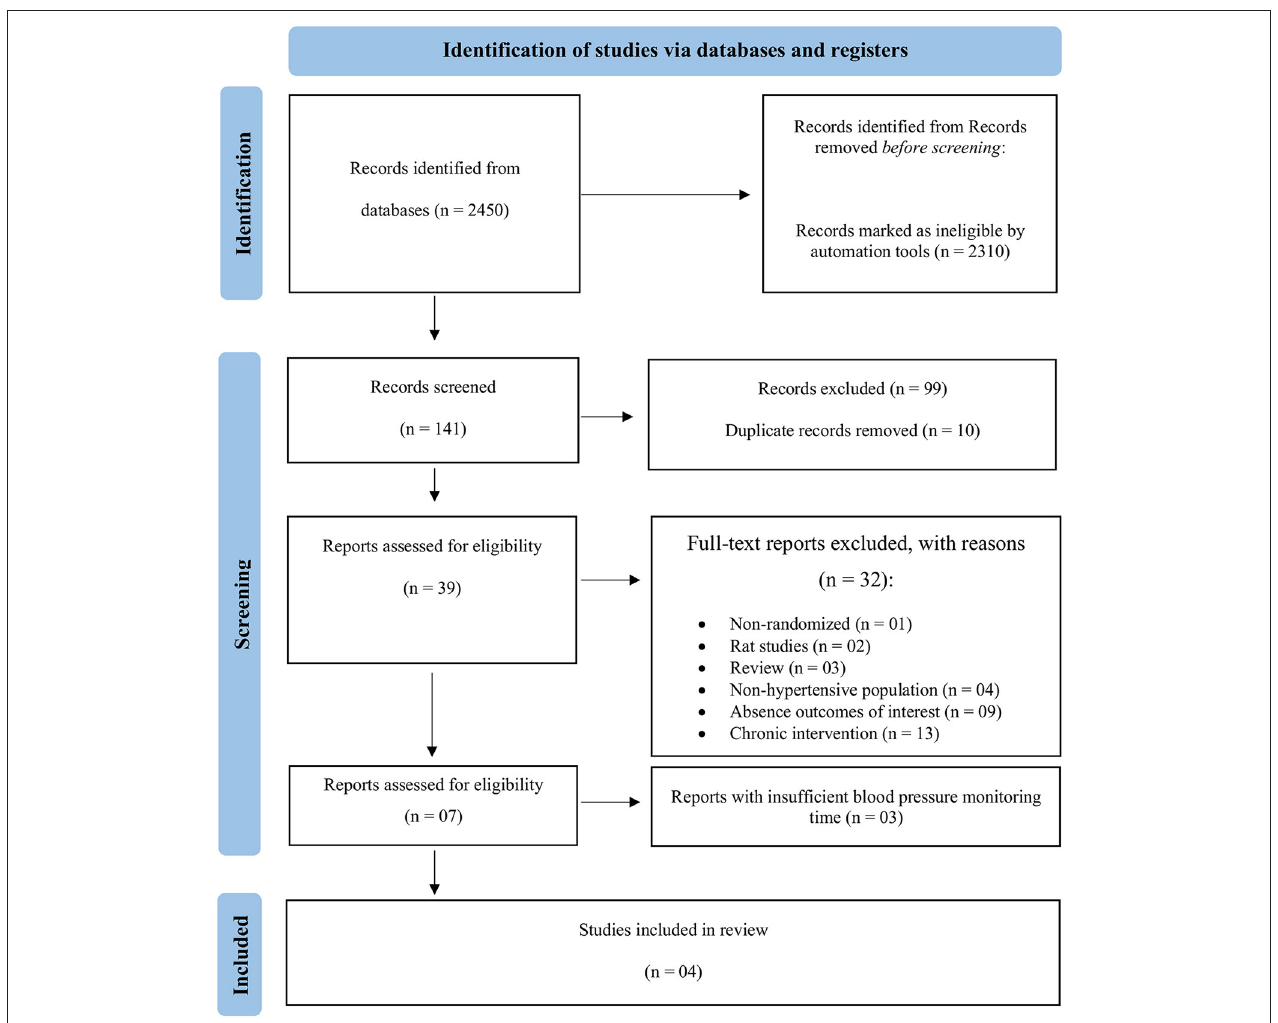
FIGURE 1 | PRISMA flow diagram showing the selection process of eligible